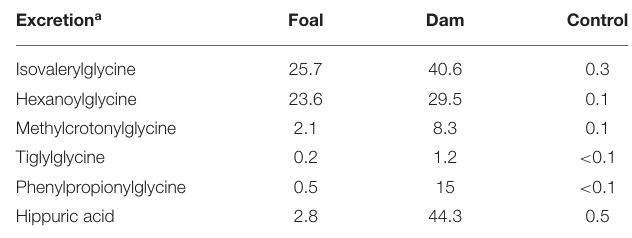
TABLE 5 | Renal excretion of acylglycines and hippuric